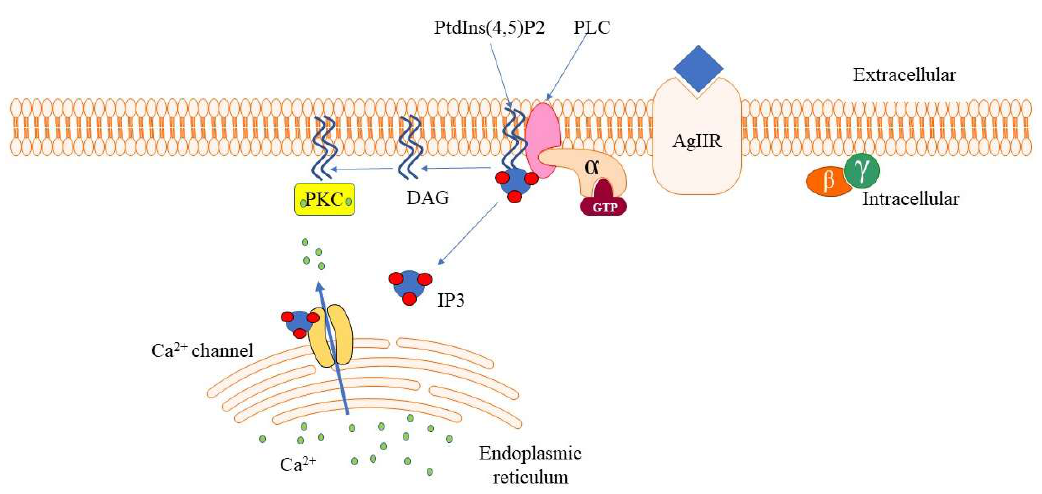
Figure 1. A cartoon representation of phospholipase beta (PLCβ) signaling. PLCβ hydrolyzes membrane-bound PtdIns(4,5)P2 to inositol 1,4,5-trisphophate (IP3) and diacylglycerol (DAG),